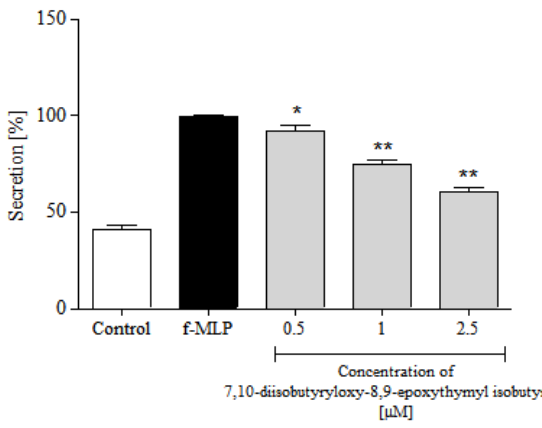
Figure 5. Inhibitory effects of 7,10-diisobutyryloxy-8,9-epoxythymyl isobutyrate, at concentrations 0.5, 1.0 and 2.5 μ M, on the ROS release from f-MLP stimulated human neutrophils. Statistical significance: * p < 0.05, ** p < 0.001, with reference to a stimulated control.